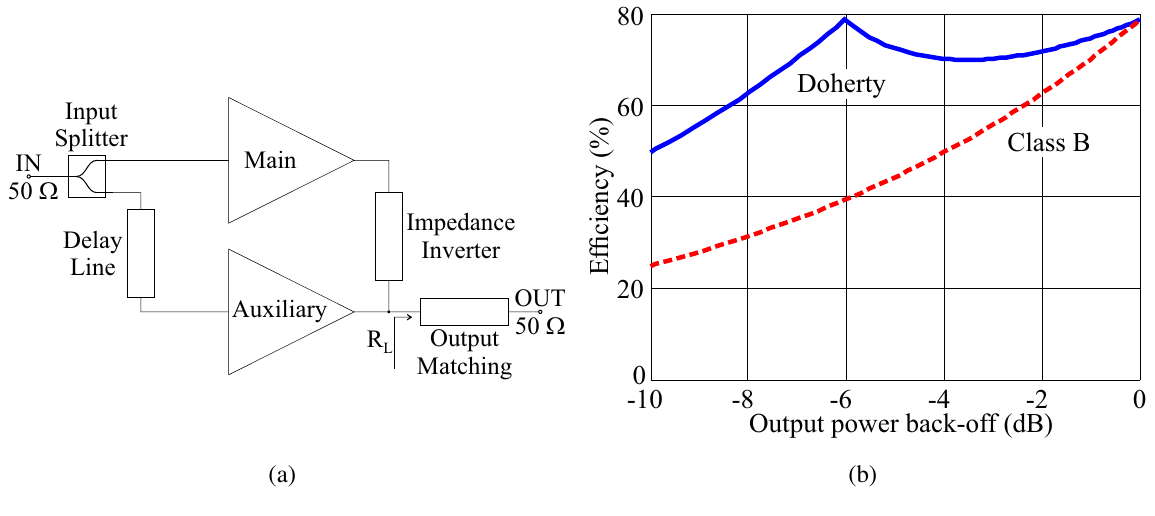
Figure 1. Block scheme of Doherty PA (power amplifier): ( a ) Efficiency vs. output power; ( b ) comparison between ideal Doherty PA and ideal class B